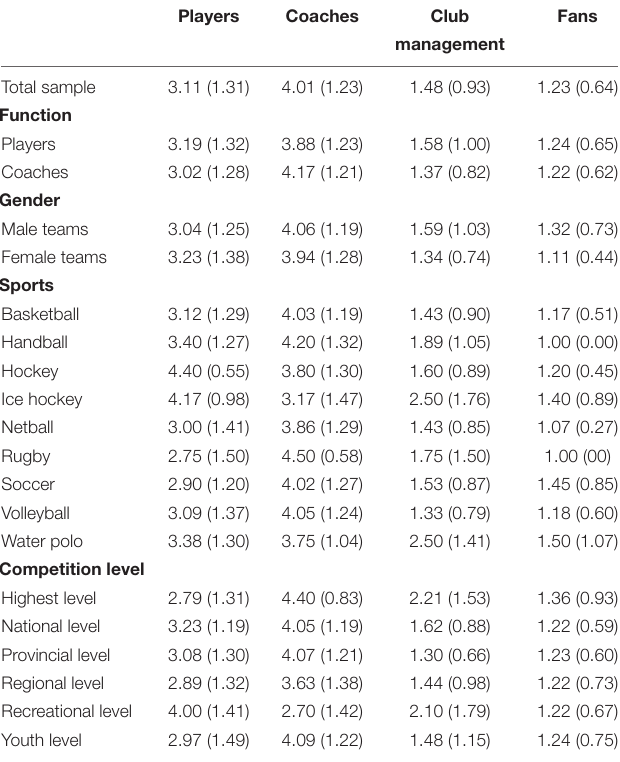
TABLE 4 | The means (with standard deviations between parentheses), reflecting the extent to which players, coach, club management, and fans influence the team captain’s selection, according to the perceptions of players and coaches, as well as male and female teams active in different sports on different competition